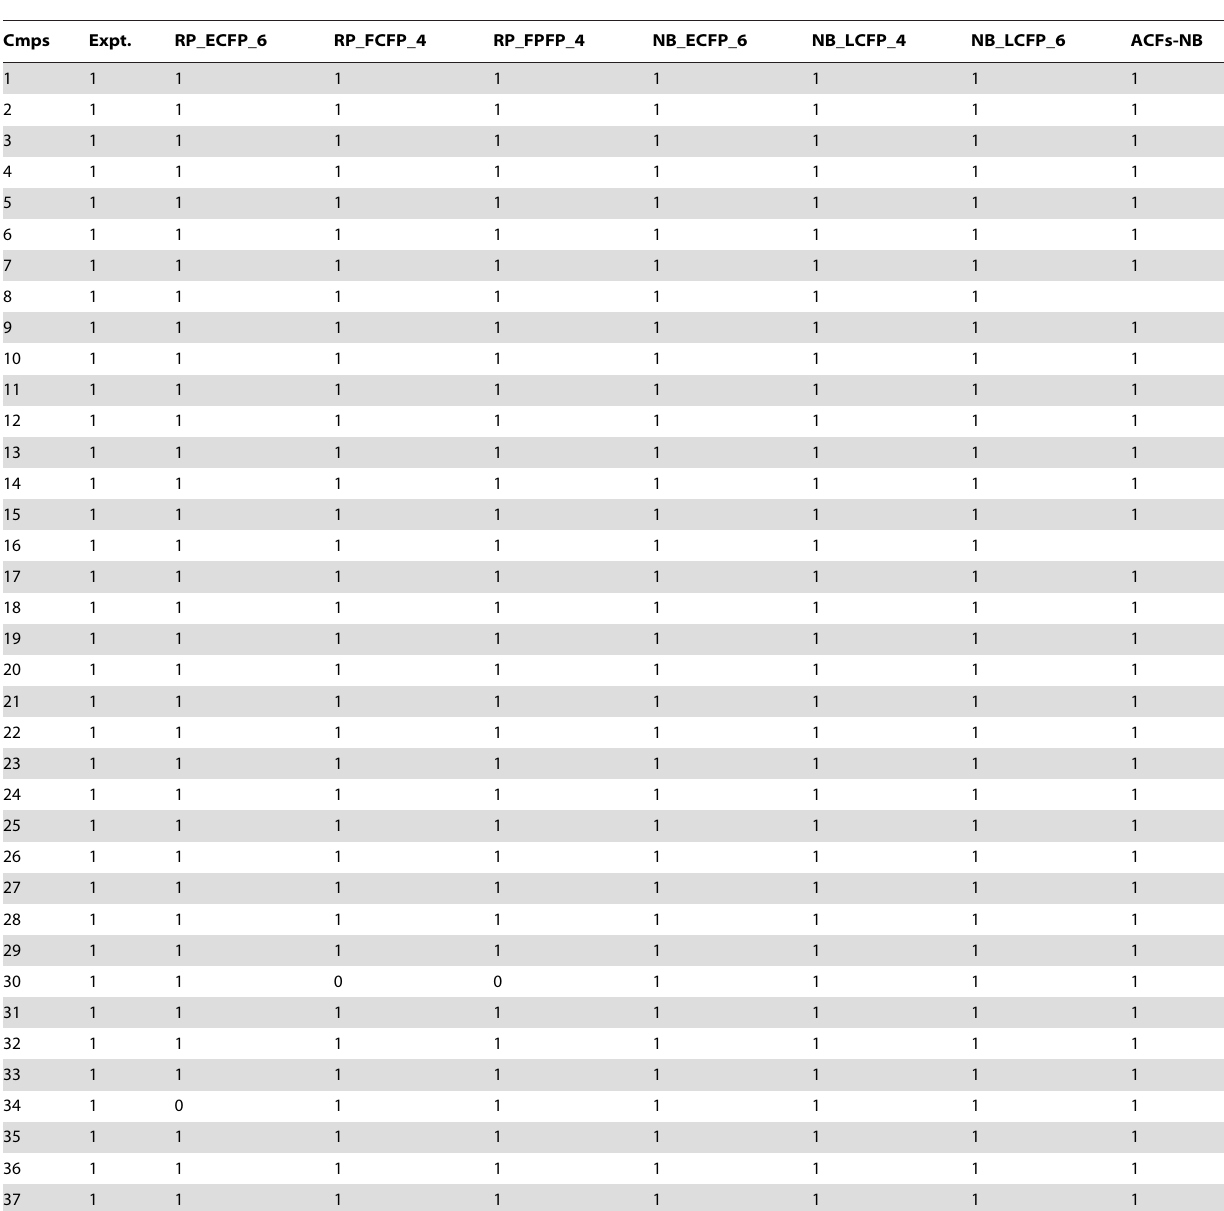
Table 3. The predictions for the 37 tested compounds using the top three RP, and Bayesian and ACFs-NB classifiers a .